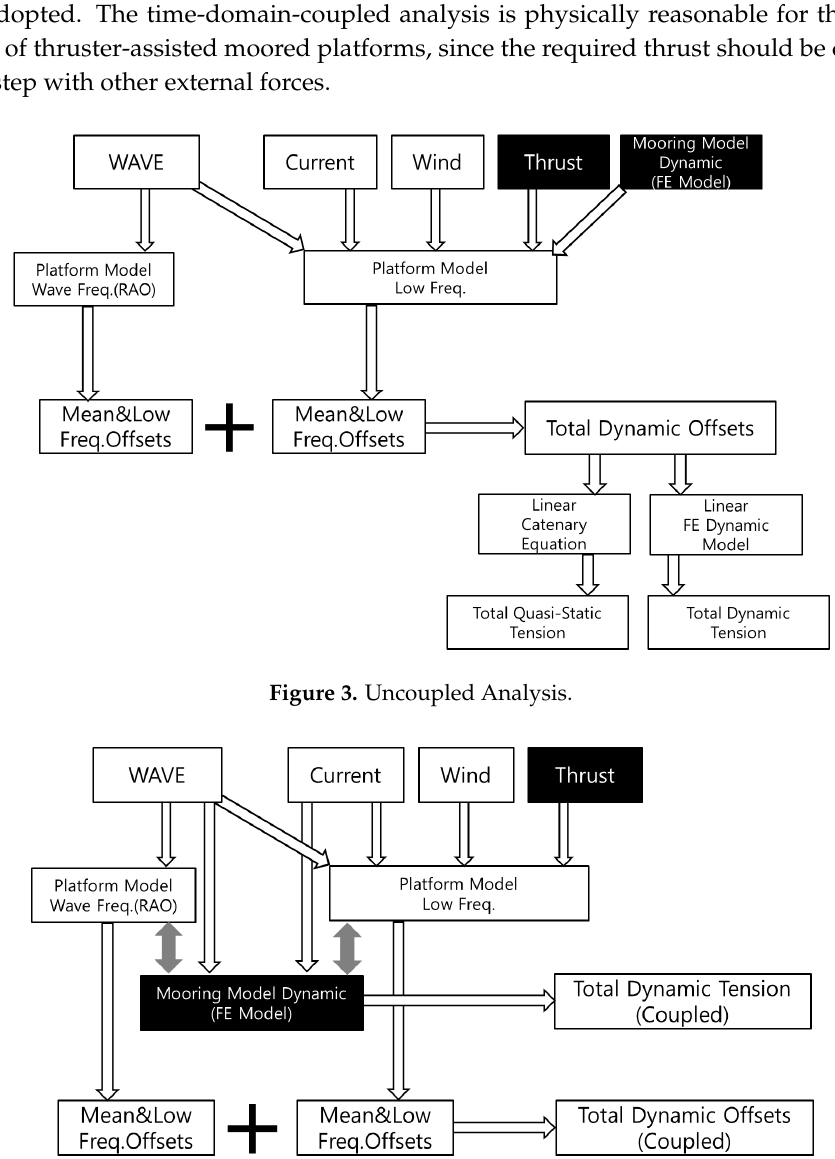
Figure 4. Coupled Figure 4. Coupled Analysis.